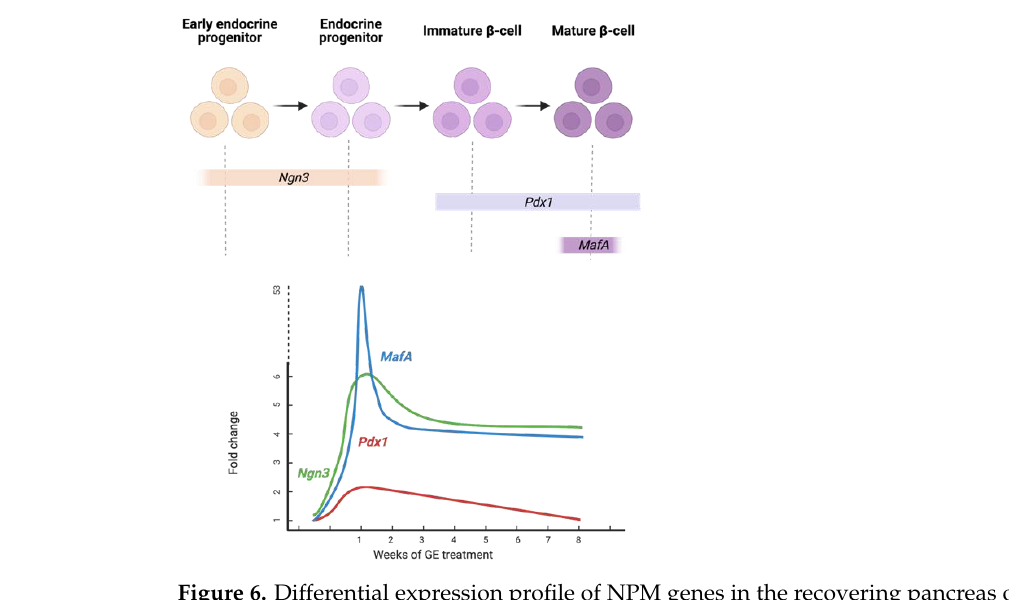
Figure 6. Differential expression profile of NPM genes in the recovering pancreas of STZ-induced diabetic rats after 1 and 8 weeks of GE treatment. MafA expression is the highest at week 1, followed by Pdx1 and then Ngn3 . Insulin-producing cells may have originated from the differentiation of immature β-cells that escaped the effects of STZ and possibly were induced by both MafA and Pdx1 to give rise to mature β-cells. Created with BioRender.com, accessed on 14 June 2022. GE, garlic extract.